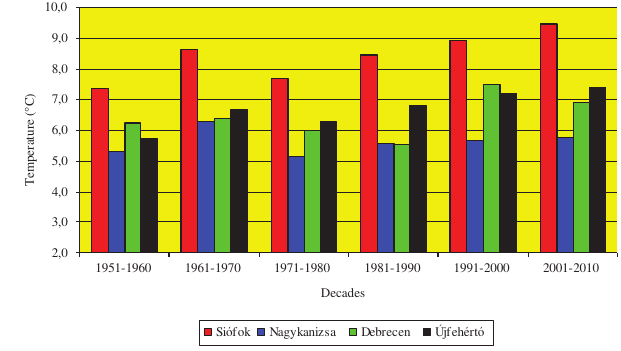
Figure 4 – The 10-year-mean temperatures of the spring season (April 1 – May 15) in four fruit growing regions over the period